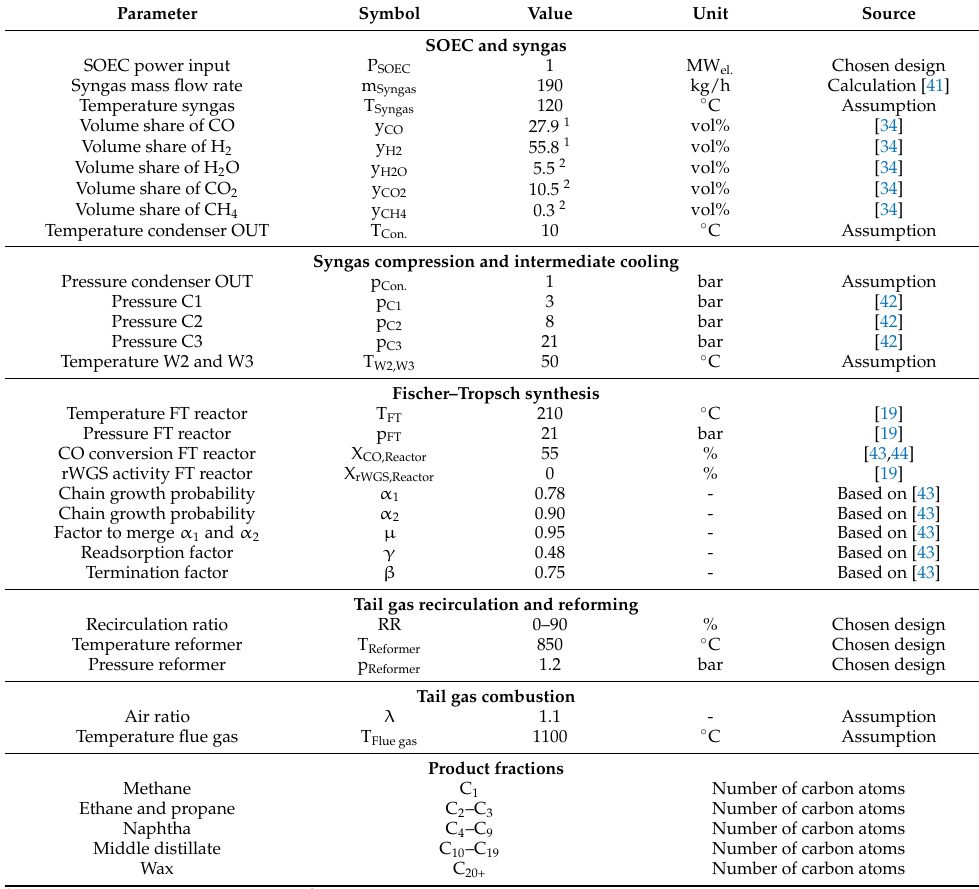
Figure 4. Implementation in IPSEpro—process configuration including tail gas reforming. Table 3 provides a list of the parameters chosen for the process simulation. Detailed explanations of the subprocesses are given within the following subsections. Table 3. Important parameters of the process